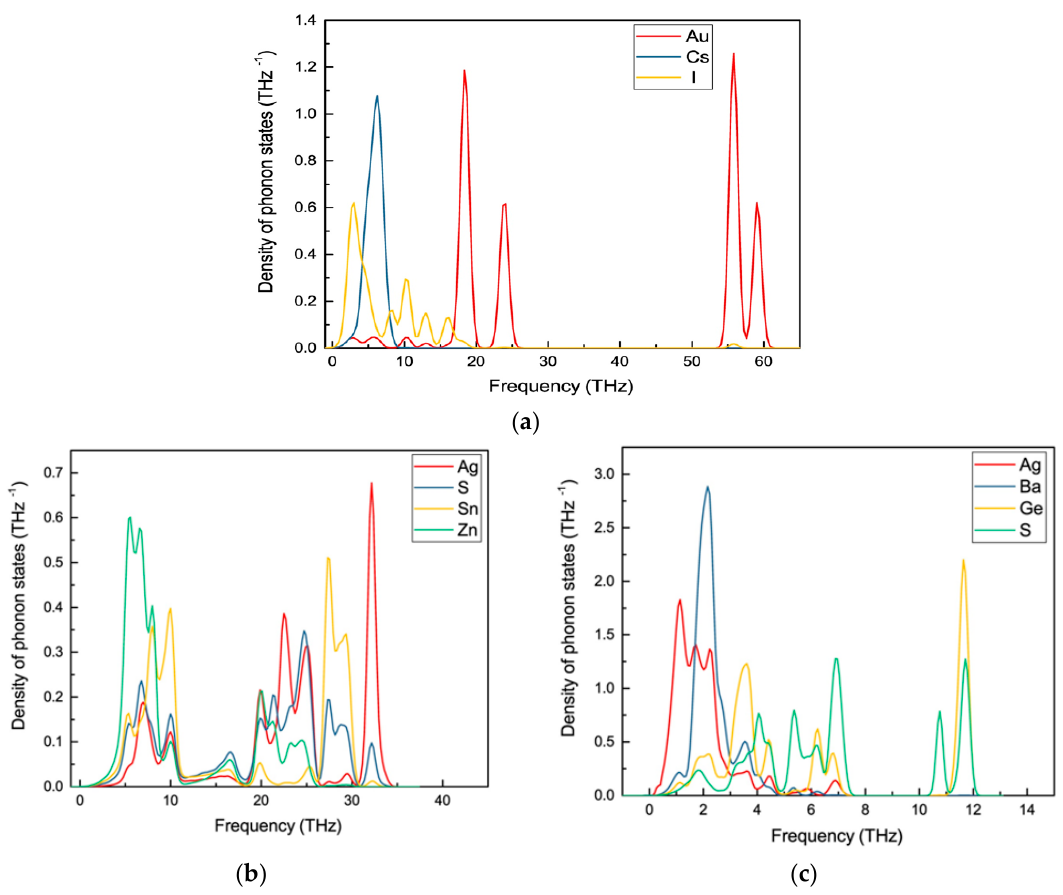
Figure 5. Calculated site projected phonon density of states for ( a ) Au 2 Cs 2 I 6 ; ( b ) Ag 2 ZnSnS 4 , and ( c ) Ag 2 GeBaS 4 phases.